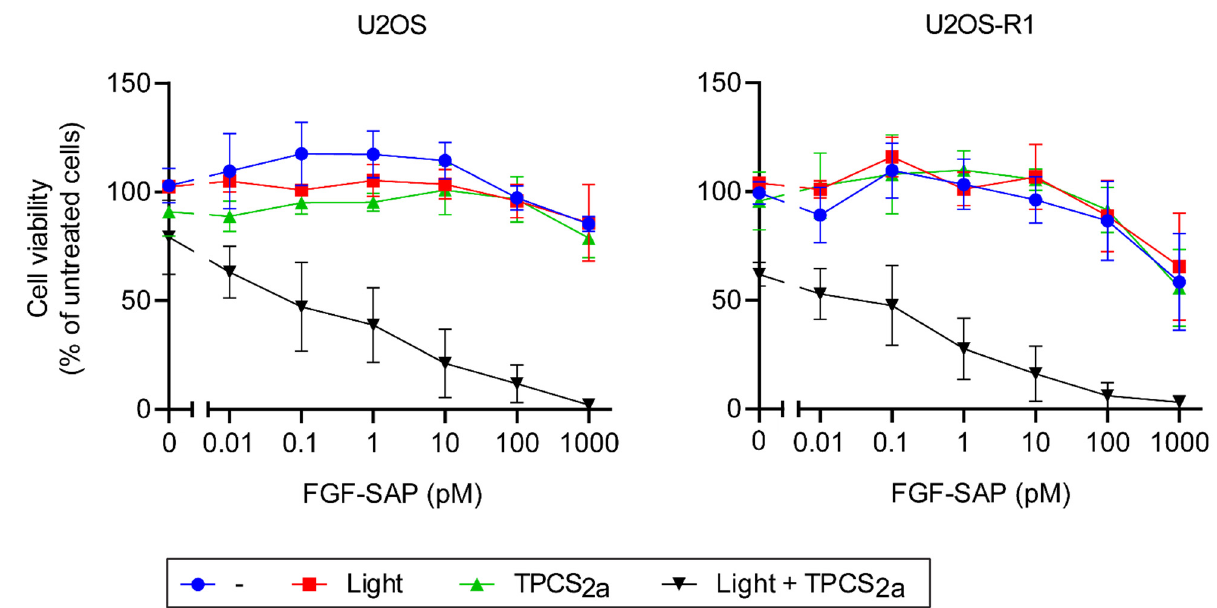
Figure 4. Cytotoxic effects of 4 h incubation of FGF-SAP with or without PCI in U2OS and U2OS-R1 cells. Cells were incubated with or without 0.2 µ g/mL TPCS 2a for 18 h prior to 4 h incubation with photosensitizer-free medium containing increasing concentration of FGF-SAP. The cells were then exposed or not to blue light for 120 s and MTS was assessed 48 h later. The following conditions were tested: drug (SAP/FGF-SAP) alone (blue), drug and light exposure (red), drug and TPCS 2a (green), drug, TPCS 2a and light exposure (black). The data are presented as means relative to the mean of untreated cells (in the case of TPCS 2a treatment, cells without TPCS 2a were included for each sample and used for normalization). The graph represents the mean of three independent experiments with three replicate samples for each condition in each experiment. Error bars ± SEM, n = 3.